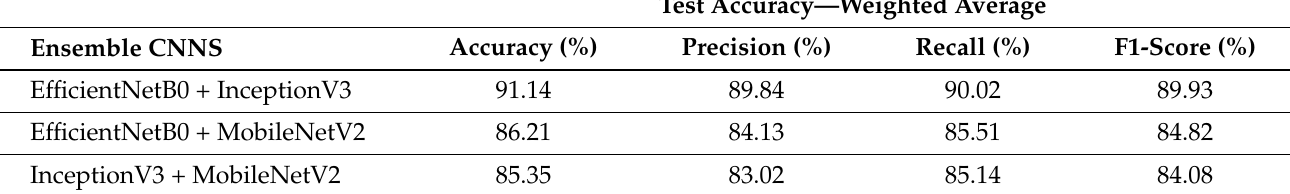
Table 6. Performance of the ensemble